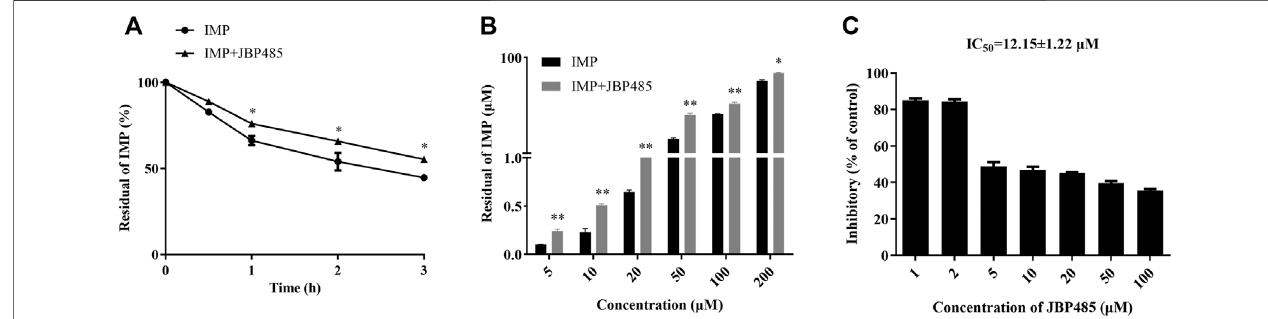
FIGURE5| EffectsofJBP485onIMPmetabolisminratkidney.MetabolismofIMP(50 μ M)byratkidneyinthepresenceorabsenceofJBP485(50 μ M)at0.5,1,2 and 3 h (A) . Concentration-dependant metabolism of IMP (5 – 200 μ M) with or without JBP485 (50 μ M) (B) . Inhibitory effect of JBP485 (1 – 100 μ M) on IMP (50 μ M) metabolism in rat kidney (C) . Data are expressed as the mean ± SD. * p < 0.05 and ** p < 0.01 compared with control ( n = 3).